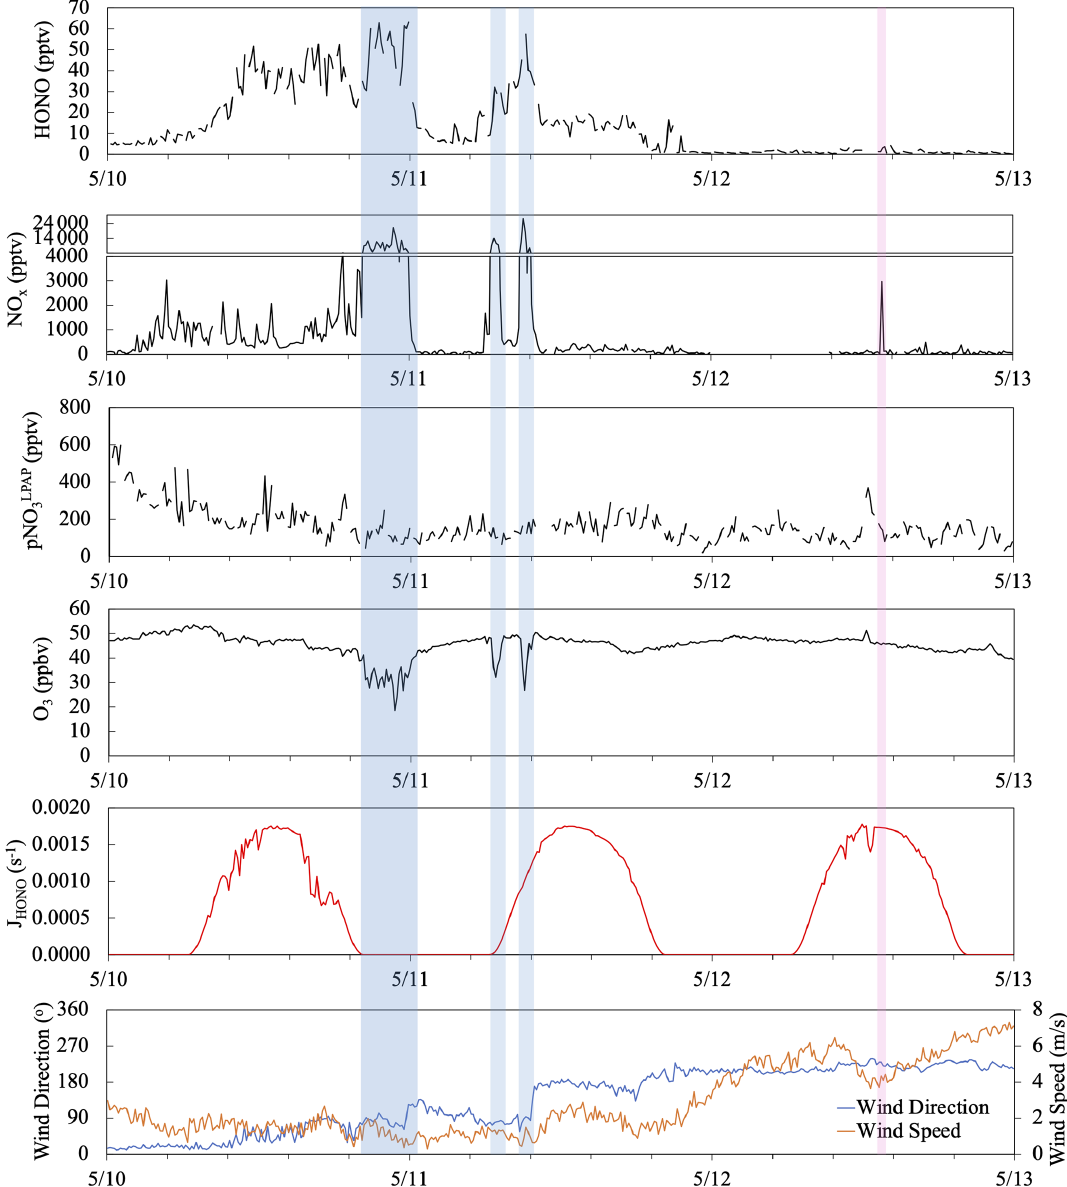
, O 3 , HONO photolysis rate constant ( J HONO ), wind direction and wind speed from Figure 9. Time series plots of HONO, NO x , pNO LPAP 3 10 to 12 May 2019. The light blue boxes highlight highly polluted periods when the Tudor Hill site received urban pollutants. The pink box highlights a short-term pollution plume that resulted from ship